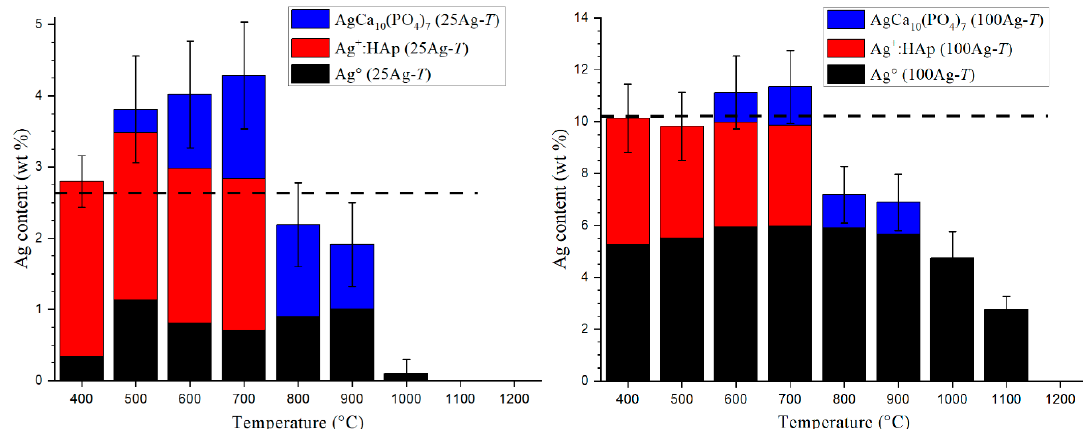
Figure 8. Cumulative silver amount taken from metallic Ag ◦ (black), substituted HAp (red), and AgCa 10 (PO 4 ) 7 (or substituted TCP, blue) for the 25Ag- T series ( left ) and the 100Ag- T series ( right ). Dotted lines indicate the nominal silver amounts, and error bars correspond to cumulative standard deviation considering the three